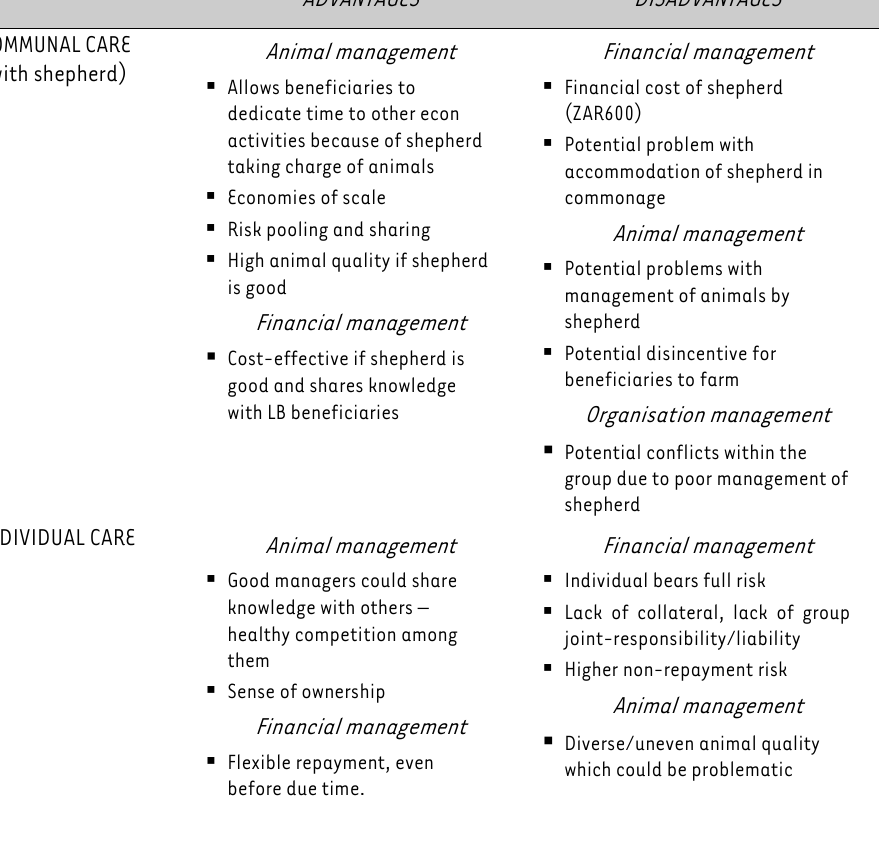
TABLE 6: Advantages and disadvantages of LB implementation of livestock care ADVANTAGES DISADVANTAGES COMMUNAL CARE (with